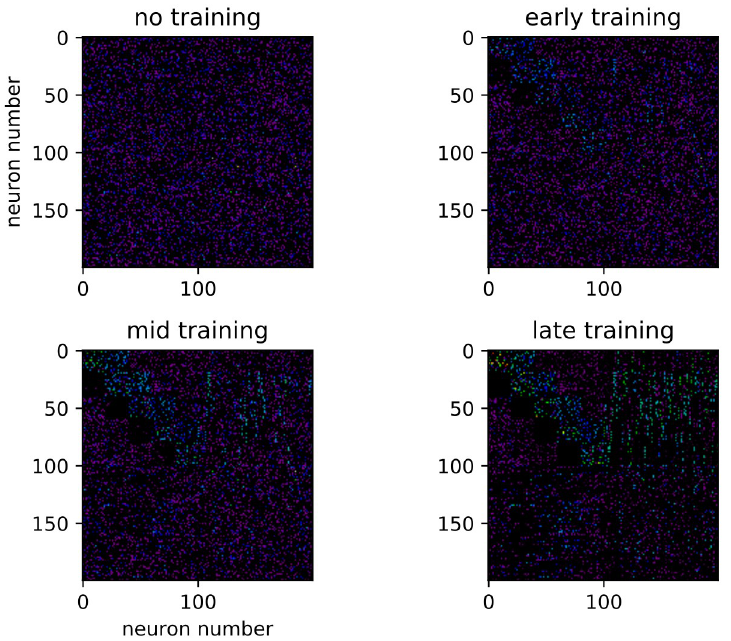
Fig 5. Sorted weight matrix throughout training. Demonstrative examples of the sorted weight matrix throughout sequence training. Arbitrary color scale.